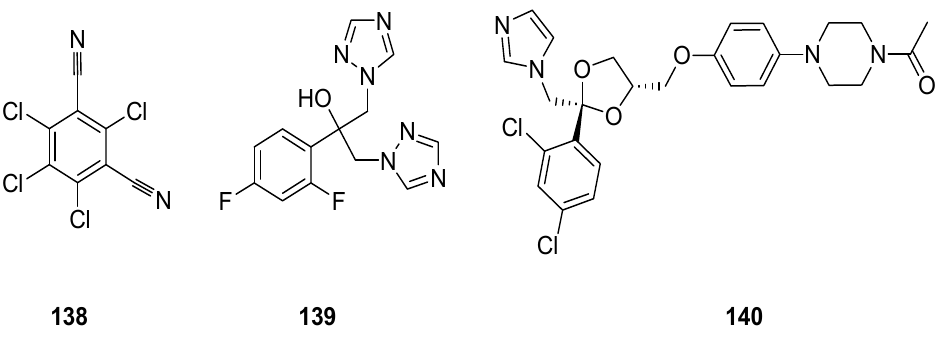
Figure 25. Potential new plant activator with thieno [2,3- d ]-1,2,3-thiadiazoles 136–137 .